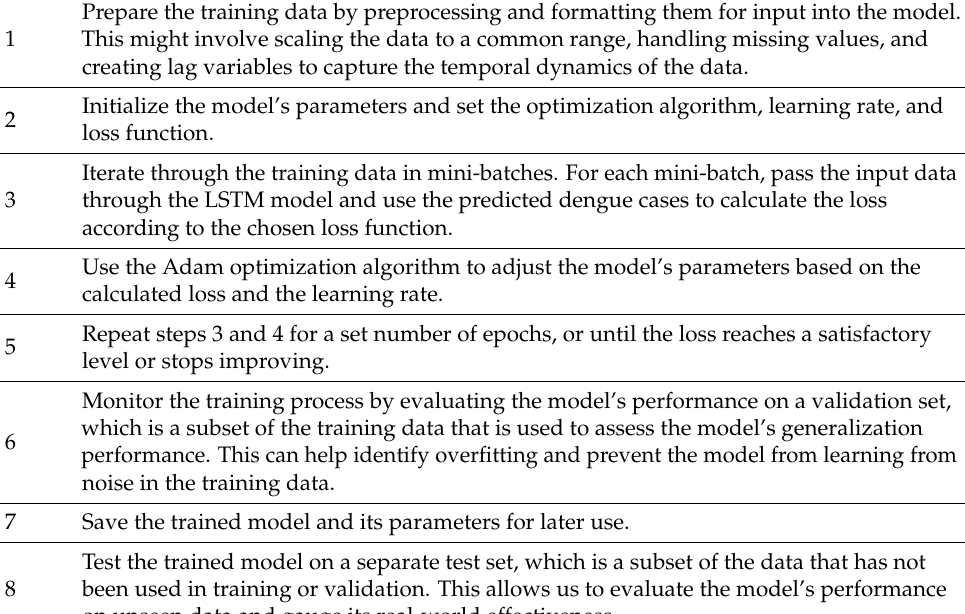
Table 1. Procedure